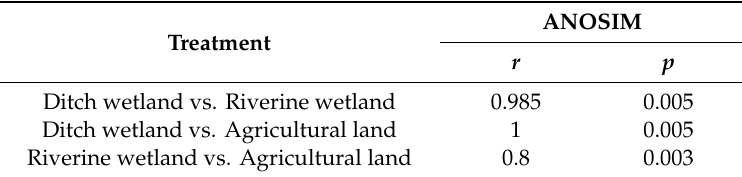
Table 3. The di ff erences of PAHs in three land use types based on the similarity test of analysis of similarity